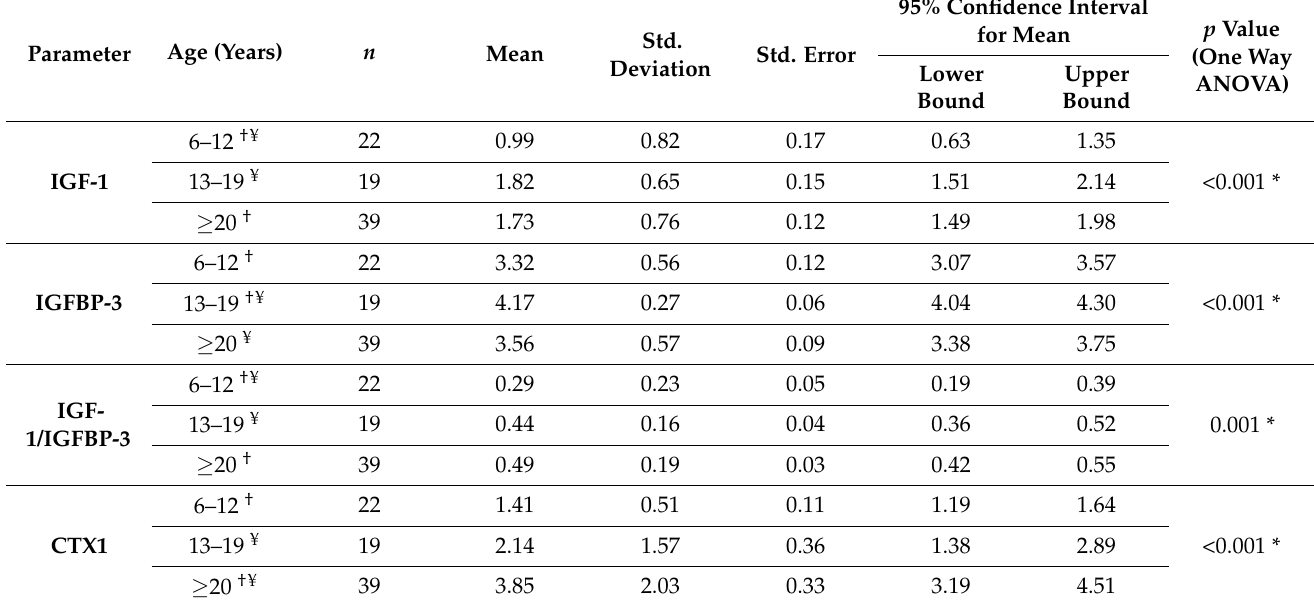
Table 2. Comparison of biochemical parameters between different age